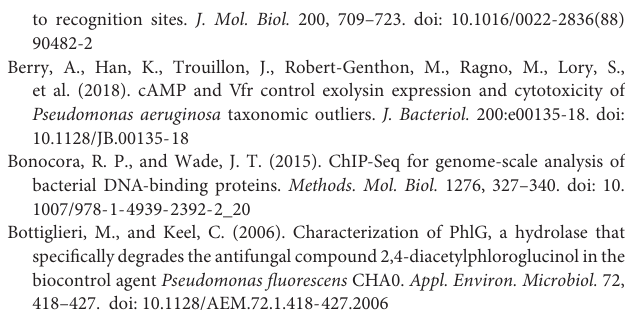
Supplementary Figure 1 | Expression of the Vfr-FLAG fusion protein. The vfr deletion mutant strains containing either the empty vector or the Vfr-FLAG fusion construct were cultured in LB broth overnight, and cell extracts were then obtained. Equal amounts of cell extracts from the two mutants were resolved by SDS-PAGE and immunoblotted to assess Vfr-FLAG fusion construct expression levels. M, Prestained Color Protein Ladder; 1, (cid:49) vfr/pBBR; 2, (cid:49) vfr/pBBR-vfr-3FLAG. Supplementary Figure 2 | Analysis of Vfr-bound genomic regions. (A) Distribution of Vfr binding regions throughout the genome. (B) Distribution of Vfr binding regions within genes. (C) Inner circular plot of the P. protegens FD6 genome indicating ChIP-seq coverage and the positions of Vfr-regulated genes. The length of the red lines indicates the degree of enrichment. Supplementary Figure 3 | SDS-PAGE of purified pET-22b-His tagged Vfr protein from E. coli BL21. M, Protein standard marker; 1, pure Vfr